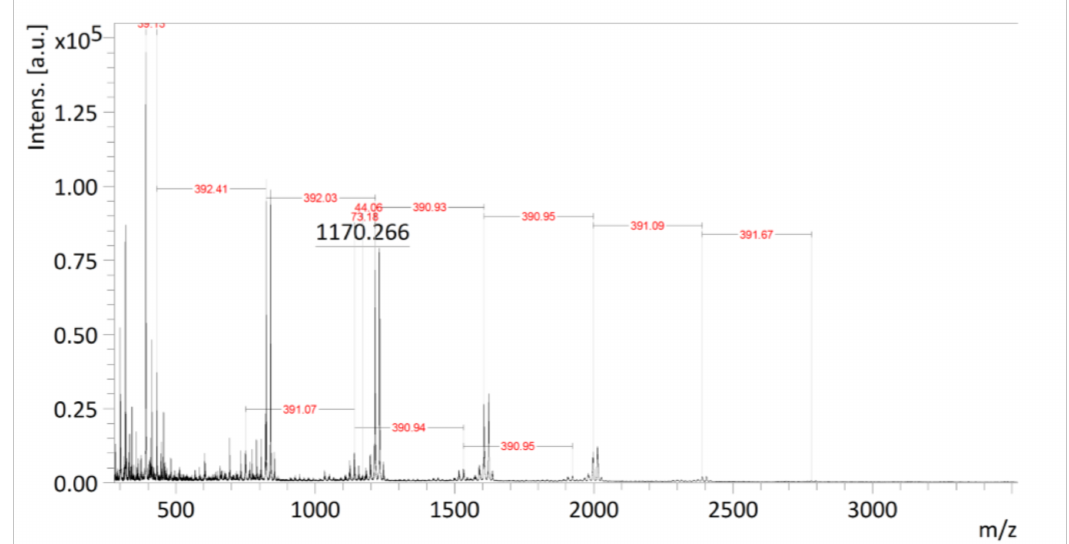
Figure 5. MALDI-TOF mass spectrum of PMDBPO. See experimental for analysis conditions.